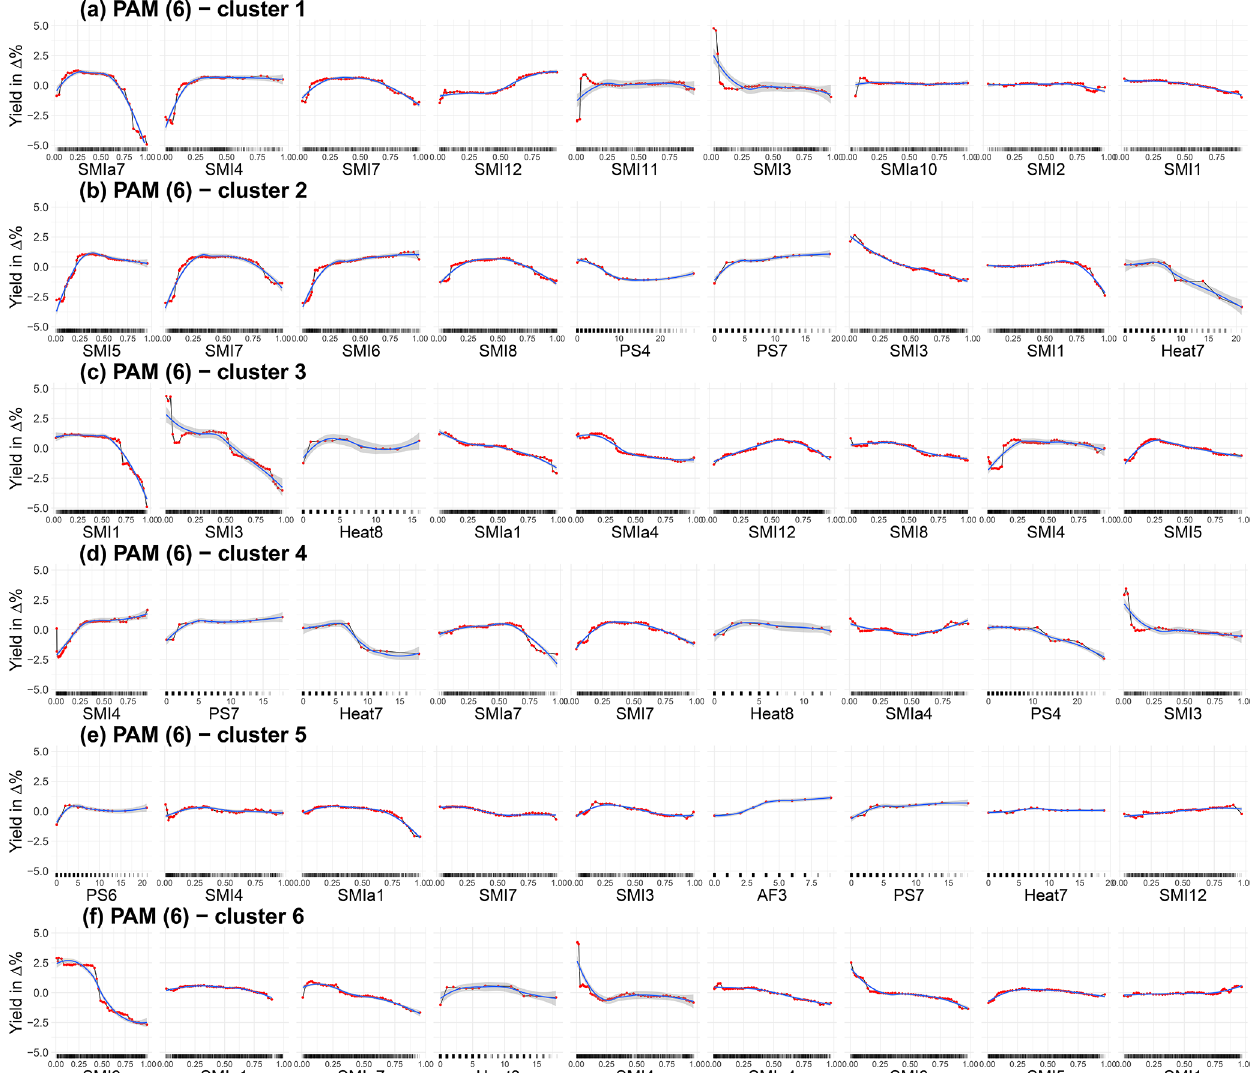
Figure A9. ALE plots for the third best combination of cluster algorithm and cluster size (PAM with six clusters) for a soil moisture index configuration that considers both the uppermost 25cm as well as the entire soil column. For the six clusters, the nine ALE plots with the highest feature importance are shown. The importance ranking is established with 50 repetitions. We have chosen a grid size of 50 to estimate the ALE plots, which allows us to reveal the true complexity of the model at the expense of shakiness. Therefore a non-linear smoothing function (LOESS – locally estimated scatterplot smoothing) is added in blue (with the confidence interval in grey). SMI represents the soil moisture index for the uppermost 25cm of the soil column, PS stands for days without rain in a given month, and Heat stands for days with a maximum temperature of more than 30 ◦ C. The number indicates the month; October (10) to December (12) refers to the year